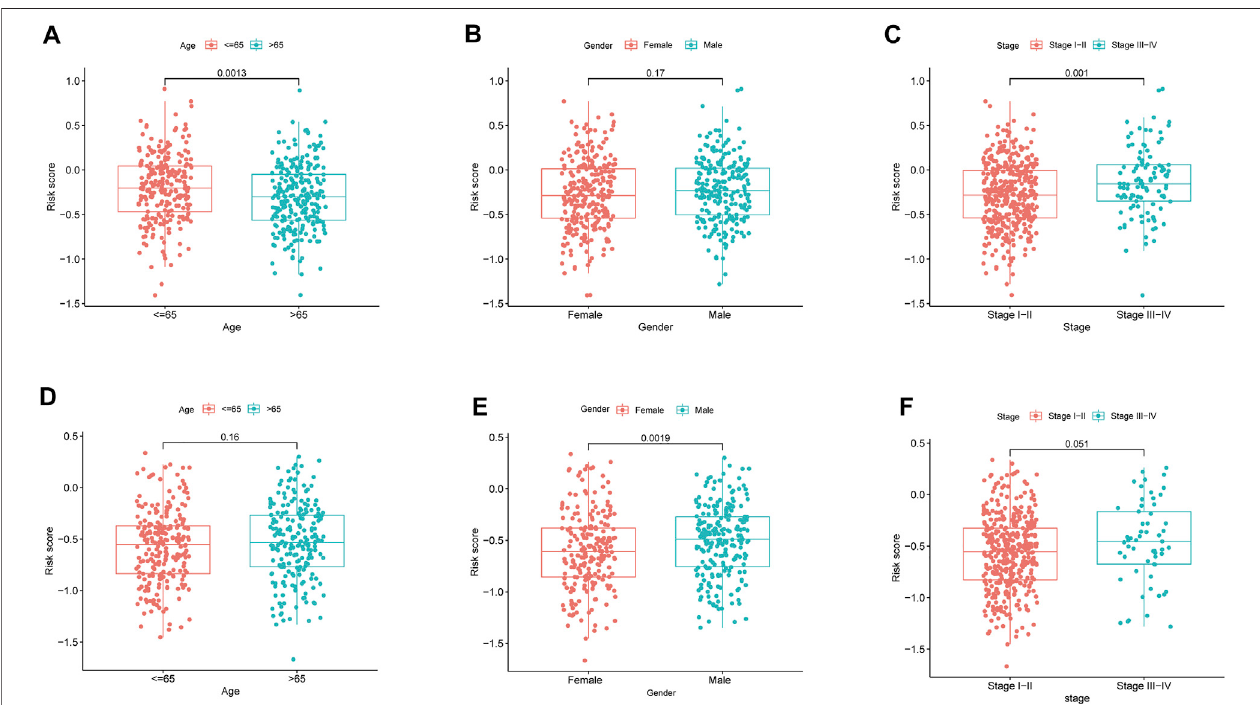
FIGURE 5 | The risk score in different groups divided by clinical characteristics. TCGA cohort (A – C) , GEO cohort (E – F) . (A,D) Age. (B,E) Gender. (C,F) Tumor